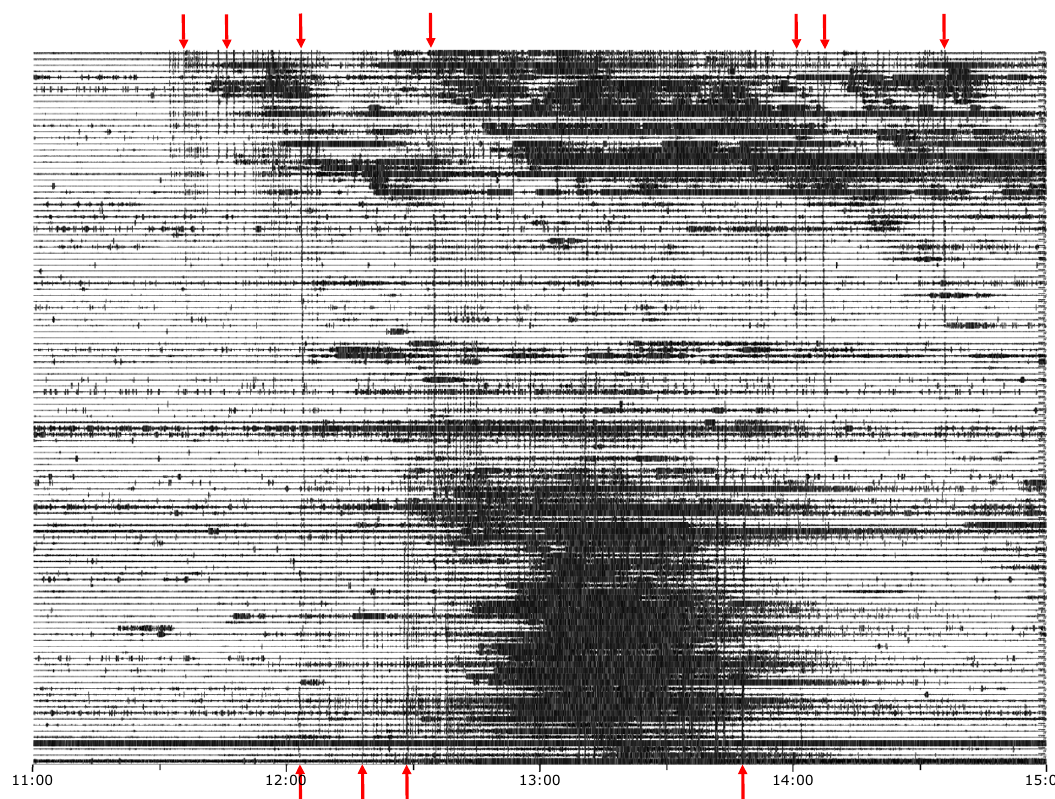
Figure 8. Four hours of seismic data recorded the 15 June 2021 (11:00–15:00 UTC) across the high-density seismic network, showing the signals generated by rainfall and thunders. The seismic data has been high-pass filtered above 30 Hz. The stations are ordered accordingly to their longitude, with the westernmost stations on top. Red arrows show some of the thunder-related signals. Red arrows highlight some of the thunder-related